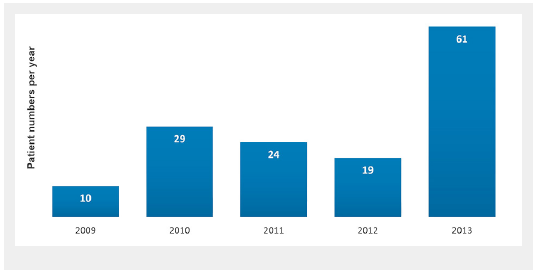
Health related data were analysed for patients admitted between 2009 and 2013 to the emergency department because of a hymenoptera sting. Here depicted are number of cases per year.